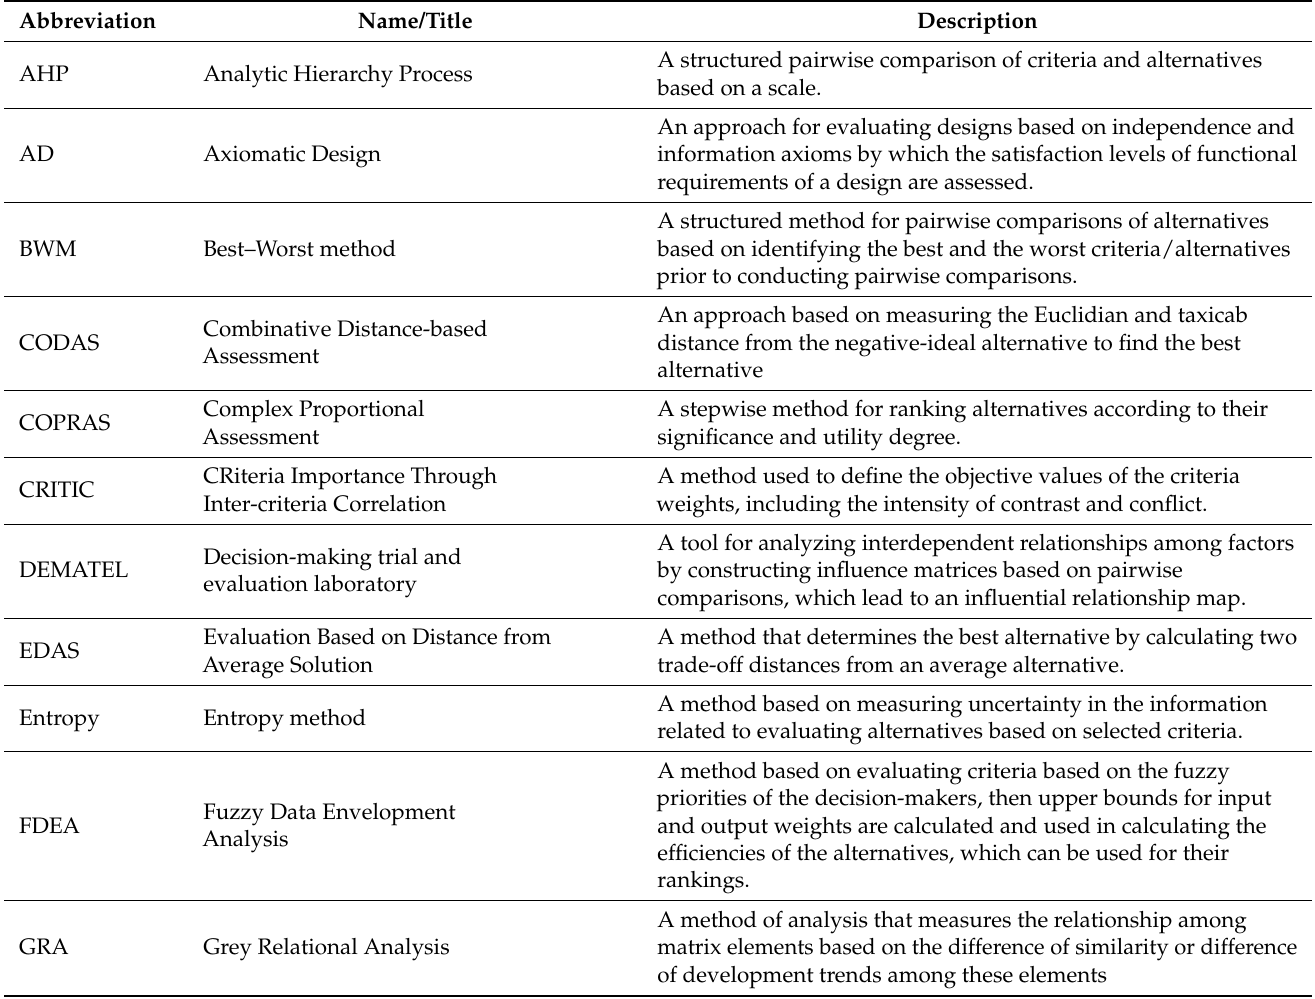
Table 1. Summary of the MCDM methods applied in the reviewed